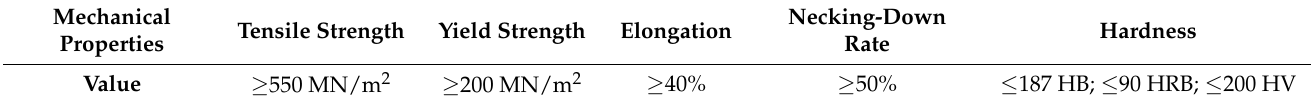
Table 2. Mechanical properties of 1Cr18Ni9Ti stainless steel.